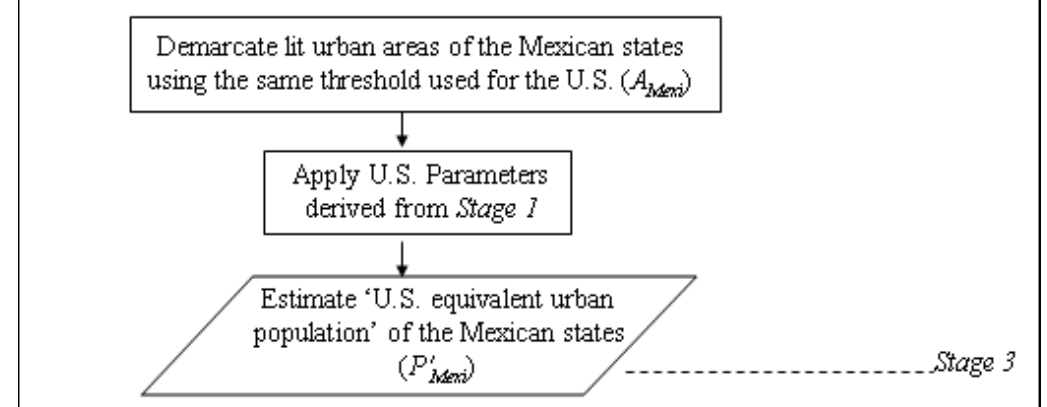
Figure 9. Stage 3 of the model: output is Estimated ‘U.S. equivalent urban population’ of each Mexican state using the U.S. regression parameters derived from Stage